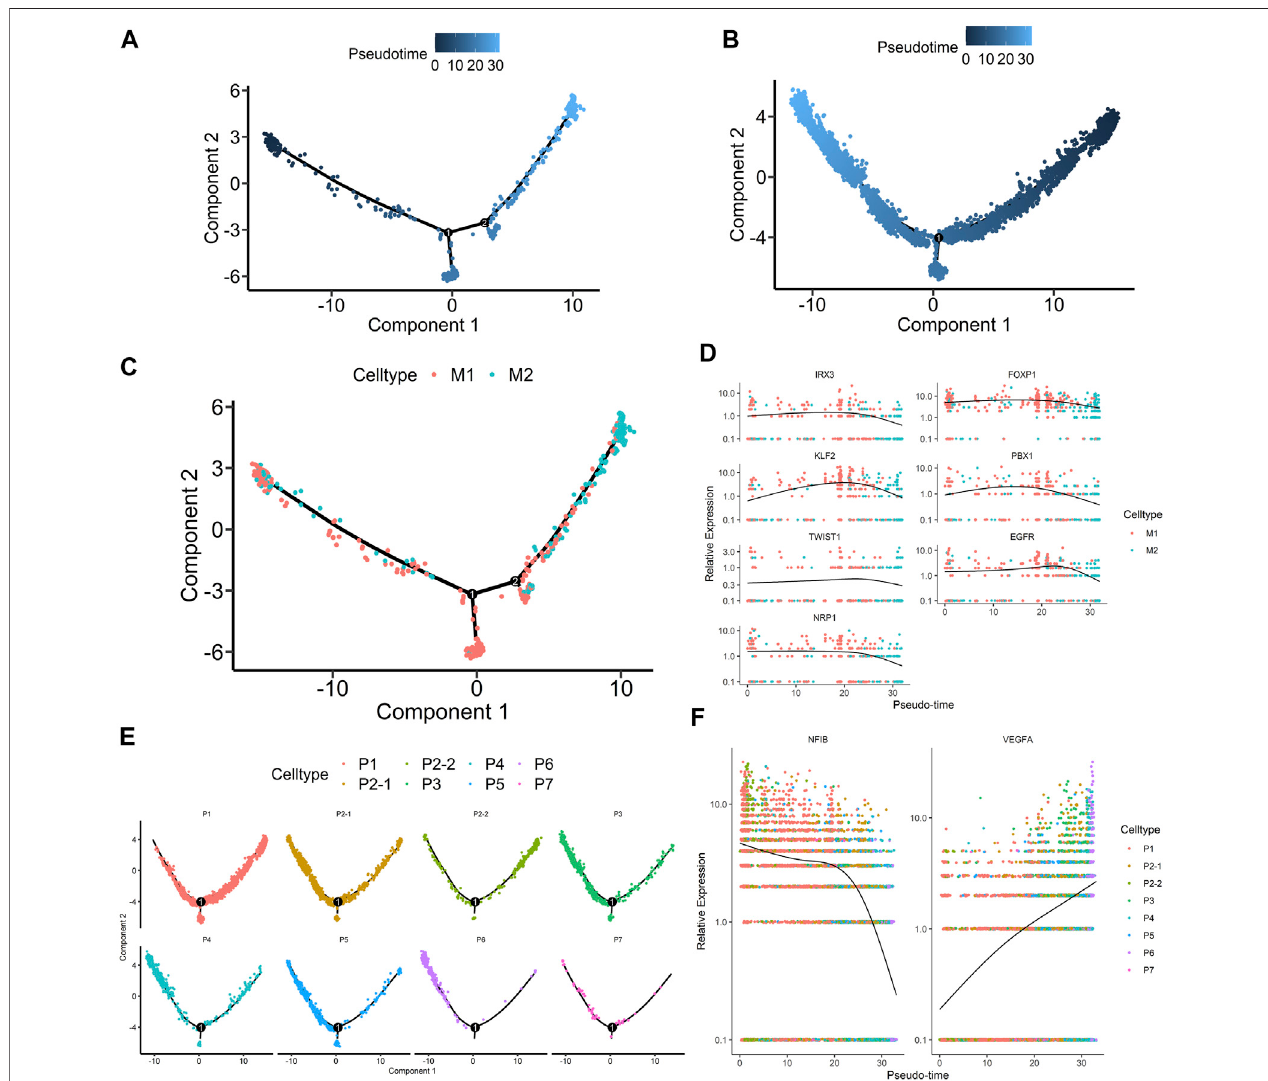
FIGURE5 | The developmentofhumanperipheral RPE and macular RPE (A-B). Trajectoryanalysisofthe transitionof thehRPE along pseudotime. The shades of color represent the order of the time (A). macular RPE (B). peripheral RPE (C). Trajectory analysis of macular RPE subpopulations over pseudotime. Cell types are distinguished by different colors (D). Pseudotime changes in important transcription factors and receptors associated with macular RPE (E). Trajectory analysis for peripheral RPE subpopulations along pseudotime. Cell types are distinguished by different colors (F). Pseudotime changes in important transcription factors and receptors associated with peripheral